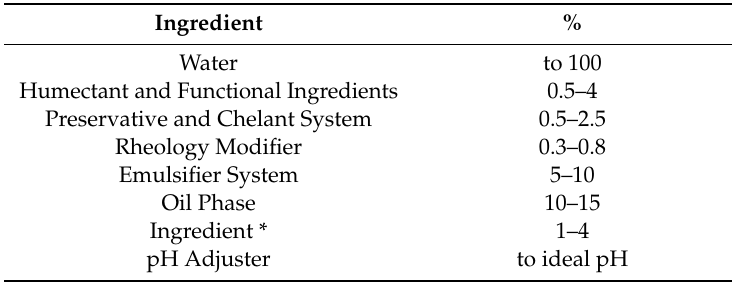
Table 1. Example of one topical formulation for atopic